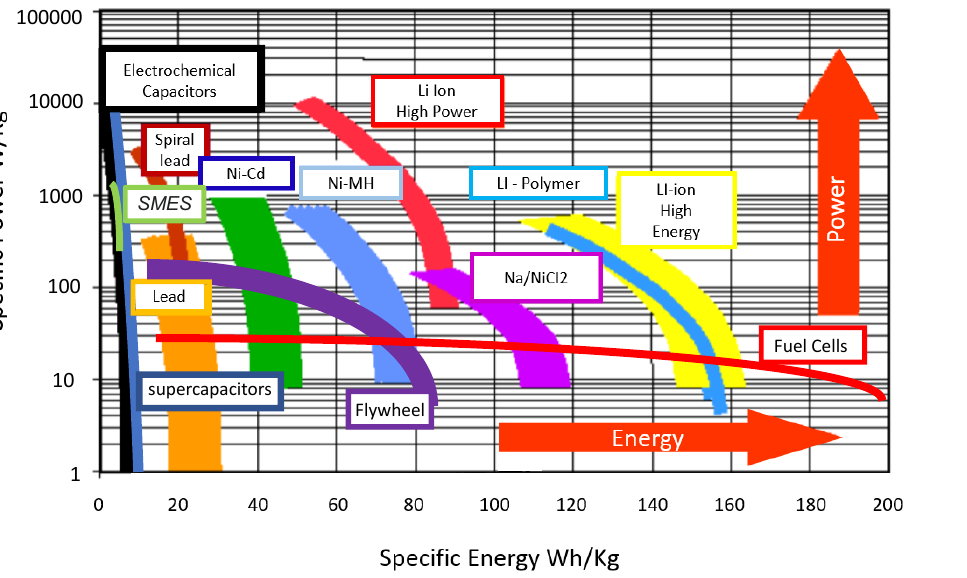
Figure 4. Ragone plot showing specific energy versus specific power for various energy-storing devices